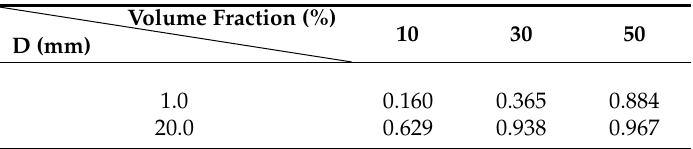
Table 5. Sedimentation results for soil of diameter 1.0 mm and 20.0 mm according to changes in volume fraction (where the soil deposition rate